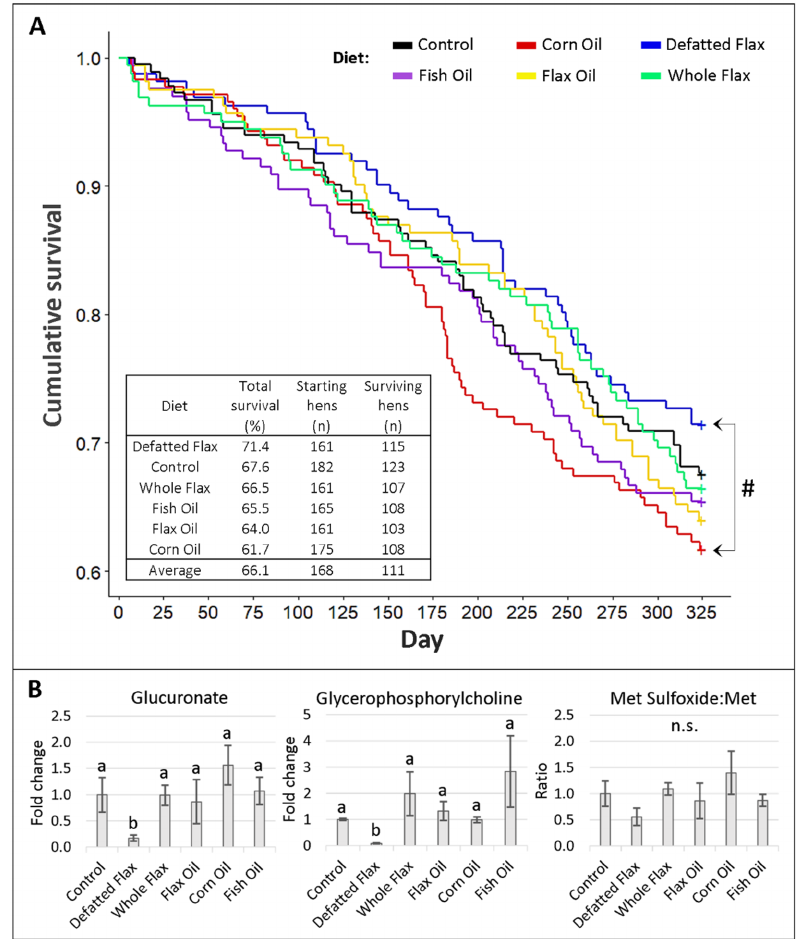
Figure 7. Kaplan–Meier survival analysis and physiological biomarkers of aging: Kaplan–Meier analysis was conducted across diet groups from day 1 to day 325 ( A ). The “#” indicates a reduced Cox proportional hazard comparing DFM hens to CRN hens (hazard exp{coef} = 0.685; p < 0.05). In addition, there are shown three biomarkers of aging, measured via LC-MS/MS ( B ). VIP scores of metabolites were analyzed via one-way ANOVA (Duncan’s post-test, p < 0.05). Groups lacking a similar letter (i.e., a,b) are significantly different. “n.s.” is used to illustrate a non-significant ANOVA. For glycerophosphorylcholine, one outlier was removed from Control, Defatted Flax, and Corn Oil. Error bars are +/ − SEM. To estimate physiological aging, we evaluated three distinct biomarkers that have been previously used to elucidate aging in human and non-human studies [69–71]. Glu- curonate, a molecule involved in urinary waste excretion, was widely lower in DFM hens versus all other diet groups, with the biggest mean difference occurring between DFM hens and CRN hens (Figure 7B). This was interesting because the Cox proportional hazard was also decreased in DFM hens versus CRN hens. Glycerophosphorylcholine (GPC), a well-known plasma osmolyte, was lower in DFM hens versus all other diet groups (Figure 7B). Lastly, the Met sulfoxide:Met ratio (a marker for systemic oxidative stress) was, on average, lowest in DFM hens (especially versus CRN hens) (Figure 7B). Altogether, we